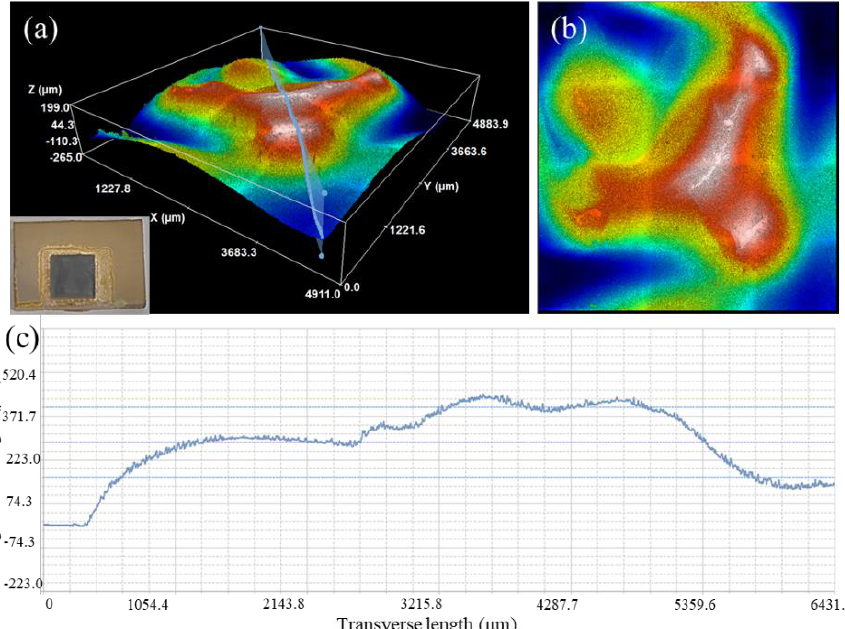
Figure 8. Fracture morphology of the joint after direct brazing. ( a ) three-dimensional view of the fracture morphology, ( b ) top-view of the fracture morphology, ( c ) height profile on the cross-section in figure ( a